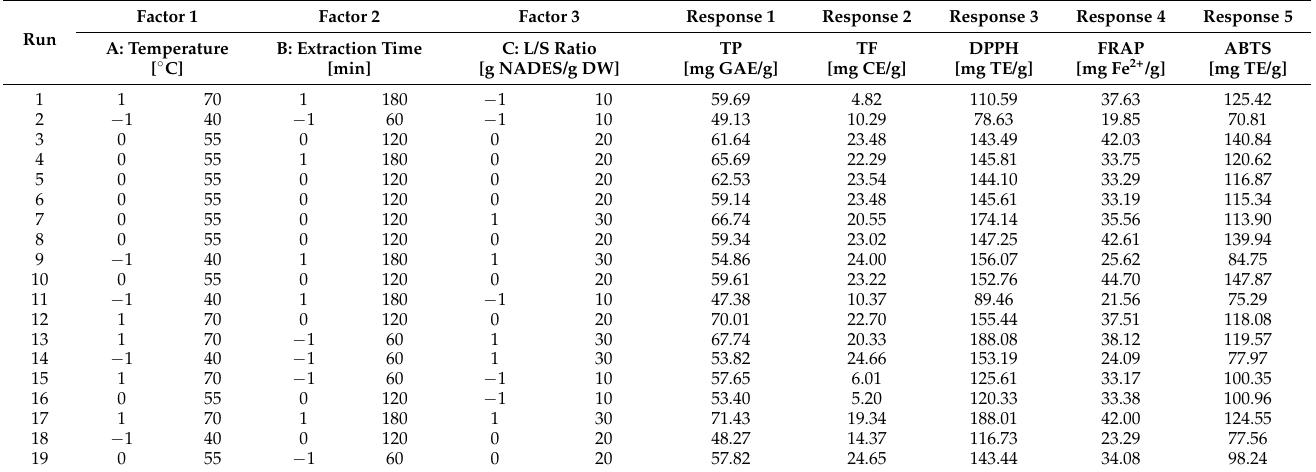
Table 2. Face-centered central composite experimental design with real and coded NADES extraction parameters and experimentally obtained values of investigated target responses (TP, TF, DPPH, FRAP and